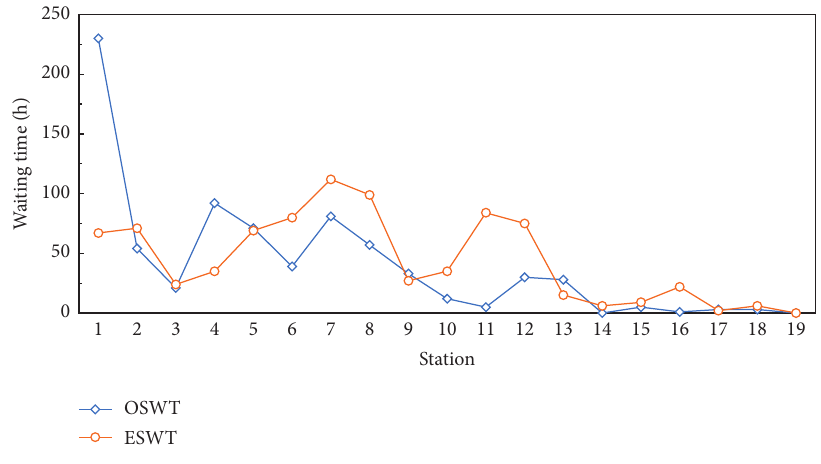
Figure 11: Passenger waiting time distribution.